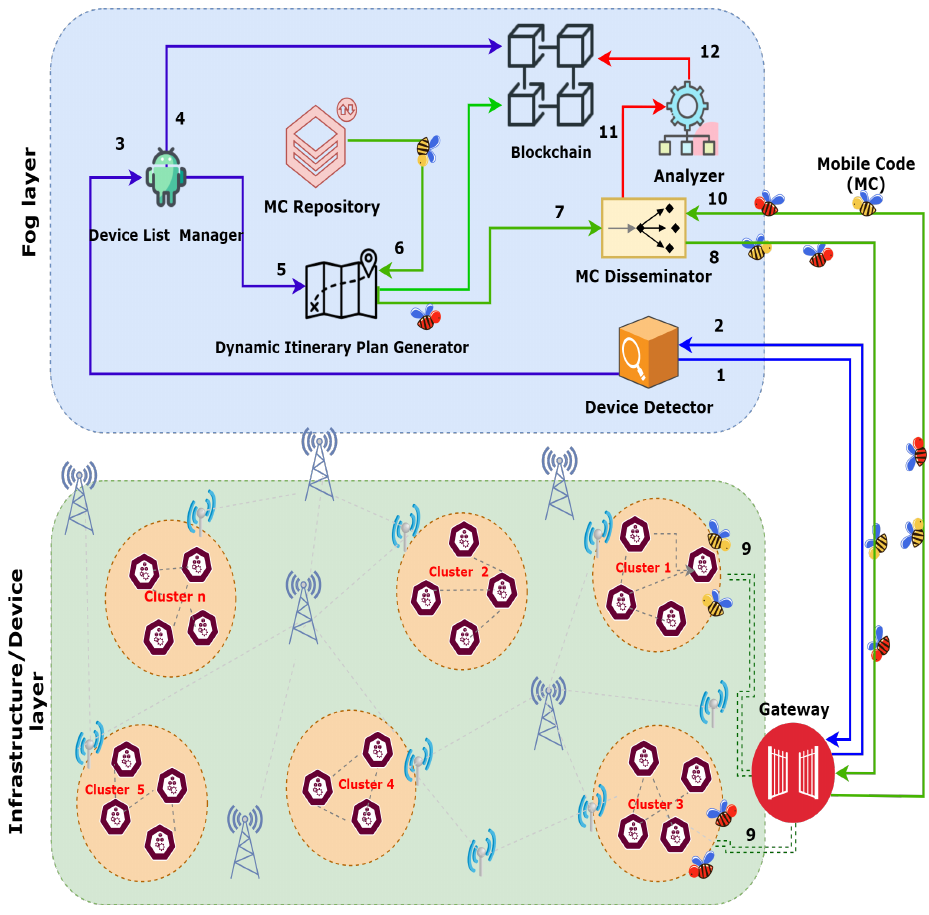
Figure 5. Process of collecting trust data from the Internet of Things (IoT)